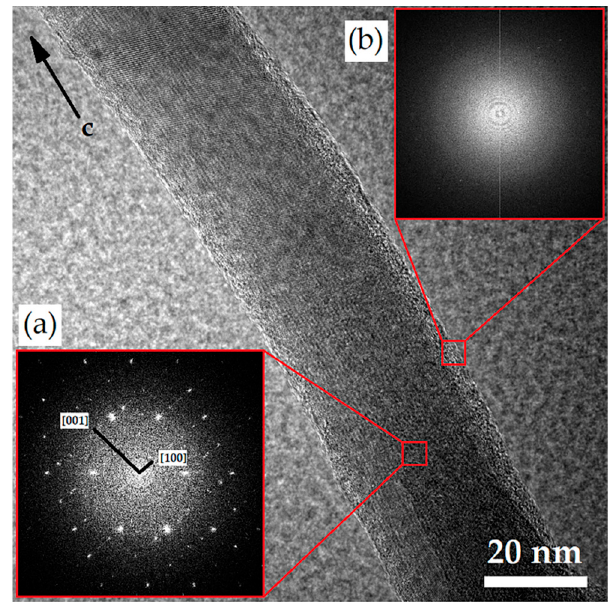
Figure 5. High resolution TEM image of a highly crystalline crocidolite fibre after a residence of ~40 y in the lung of the subject. ( a ) FFT pattern of the core of the fibre; ( b ) FFT pattern of the thin amorphous surface layer. The black arrow indicates the direction of the crystallographic c-axis.